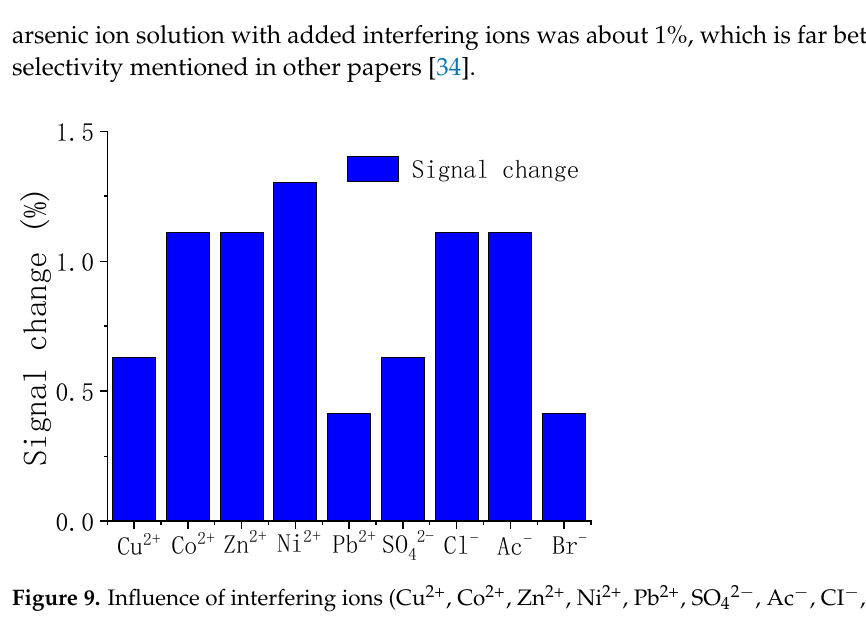
11 of 14 Figure 8. ( a ) SWV response of Fe 3 O 4 –rGO/GCE towards As(III) under pH 3 phosphate buffer, −0.4 V deposition poten- tial, and 8 μL drop volume; ( b ) relation between the peak current and As(III) concentration under pH 3 phosphate buff- er, −0.4 V deposition potential, and 8 μL drop volume. Table 1. Comparative study on the performance of different electrochemical sensors for As(III) detection. Electrode